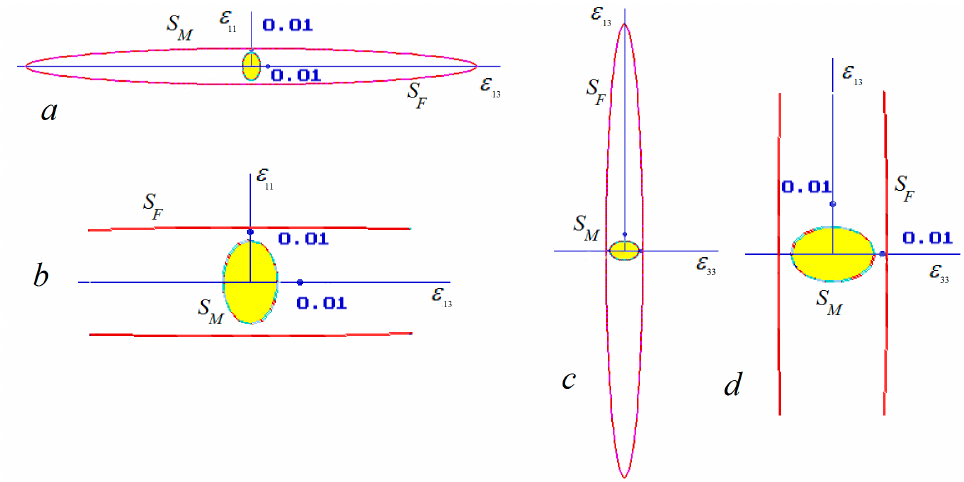
ε , ( b )—enlarged, and ( c )—in 11 13